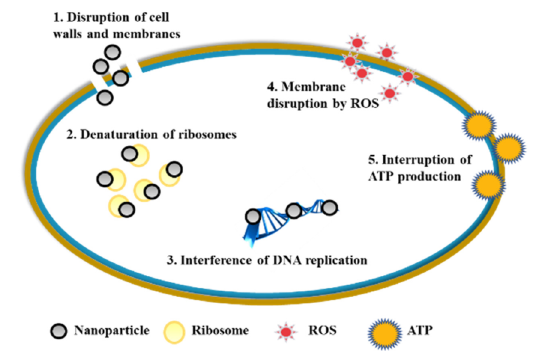
Figure 1. The antibacterial mechanism of mental